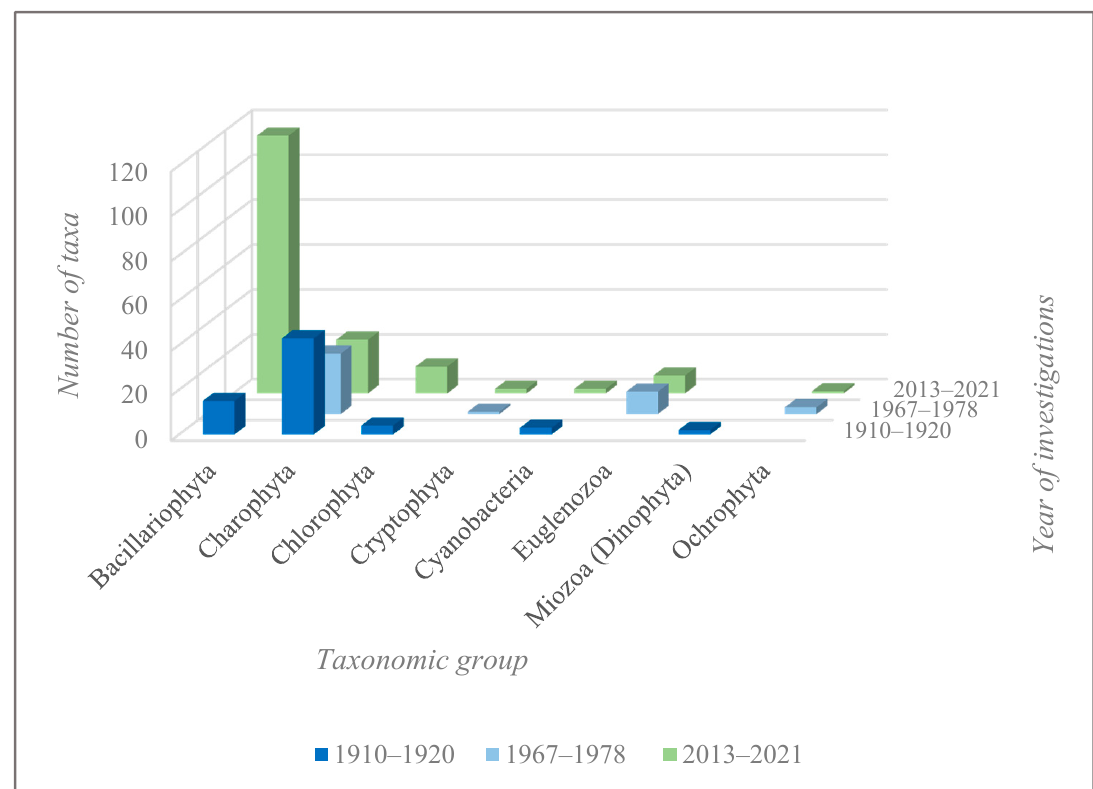
Figure 2. Species composition of algae and cyanobacteria in the Nesamovyte Lake (split by taxonomic groups and three stages of research in 1910–2021).